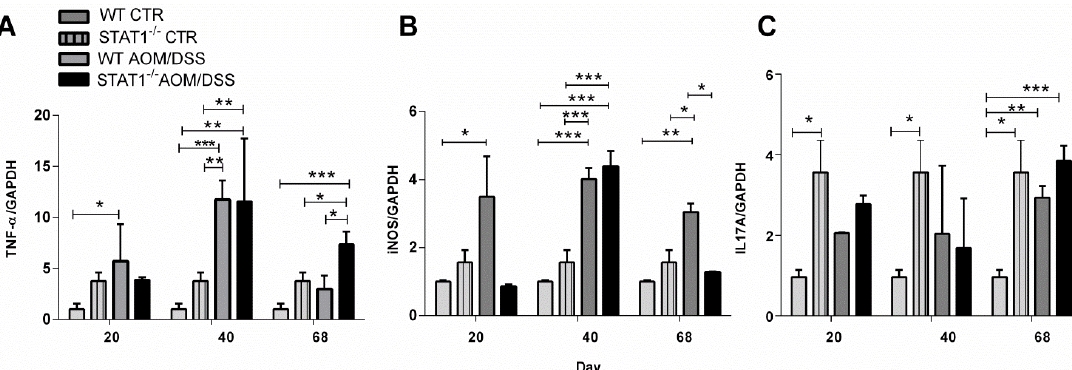
Figure 6. STAT1 can modulate the inflammatory responses involved in tumor development. RT-PCR analyses of ( A ) TNF- α , ( B ) IL-17A, and ( C ) iNOS were performed on total RNA extracted from distal colons at indicated times and were normalized to GAPDH mRNA levels. Data are expressed as mean ± SEM and are representative of two independent experiments with at least three mice per group per day of the analysis. * p < 0.05, ** p < 0.01, *** p < 0.001.